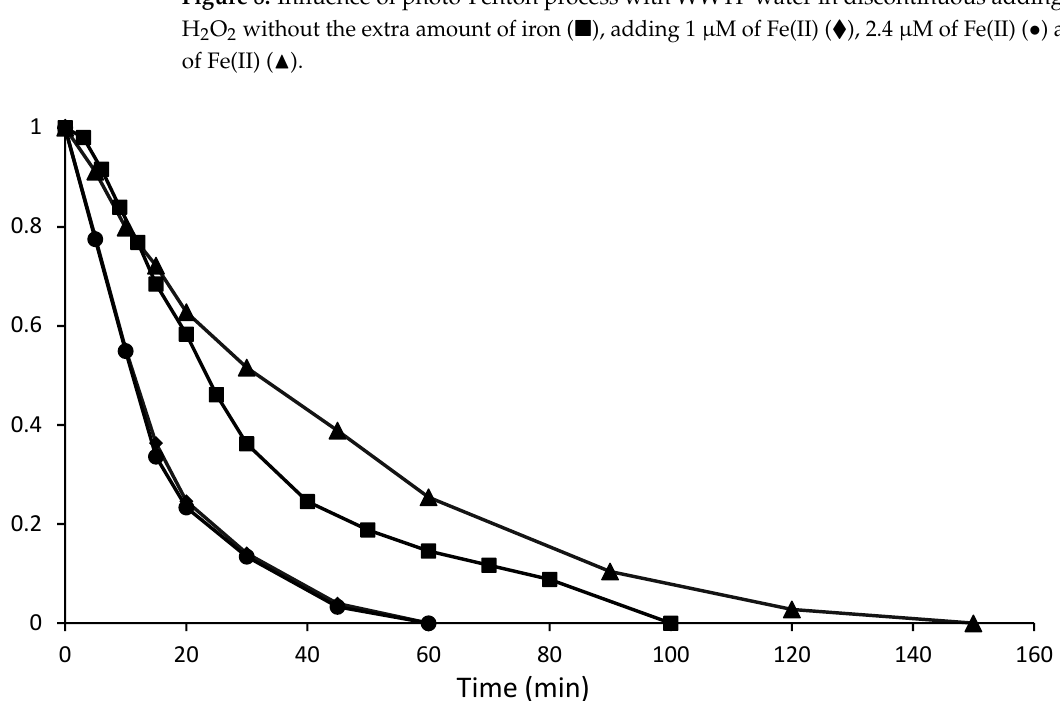
Figure 9. Influence of settleable solids on coagulation-flocculation process using UVC irradiation with acetaminophen 1 mg/L in WWTP2 ( ▲ ), WWTP1 ( ■ ), c-f-WWTP2 spiked with acetaminophen ( (cid:7) ) and WWTP2 spiked with acetaminophen and submitted to coagulation-flocculation process ( • ).